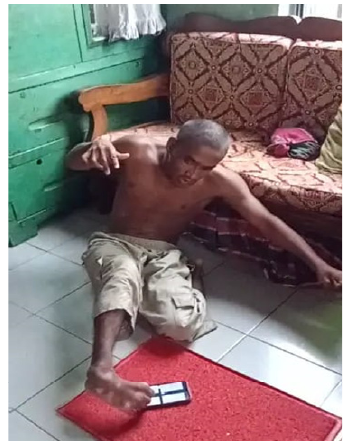
Figure 5. Alt-text: Young man sitting on a white tiled floor, using his foot to operate his phone.